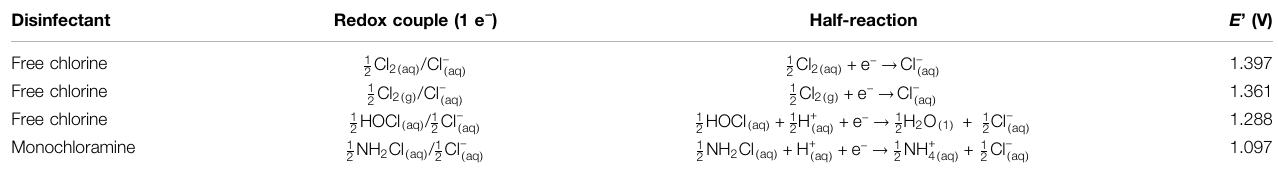
TABLE 2 | The oxidation-reduction (redox) potentials of free chlorine and monochloramine.